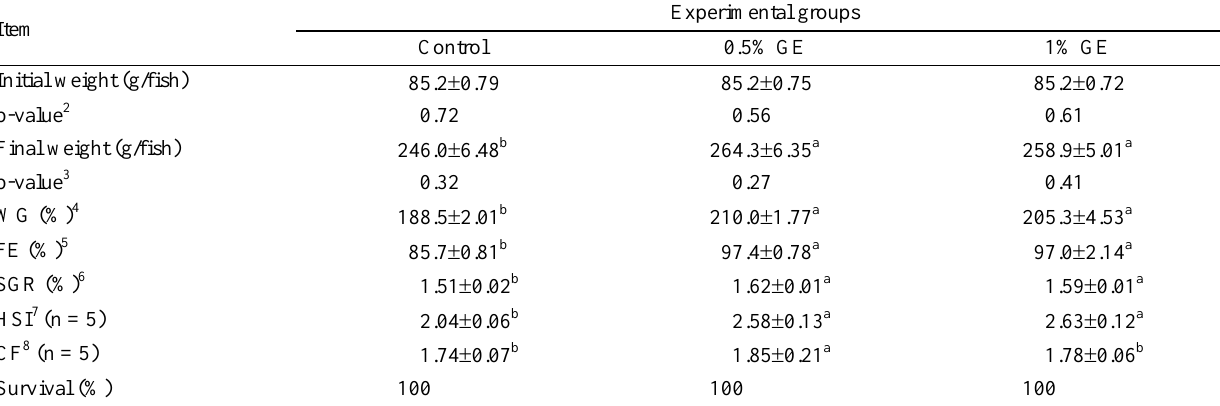
Table 1. Growth performance of juvenile sterlet sturgeon fed diets with or without garlic extracts (GE) for 10 wk 1